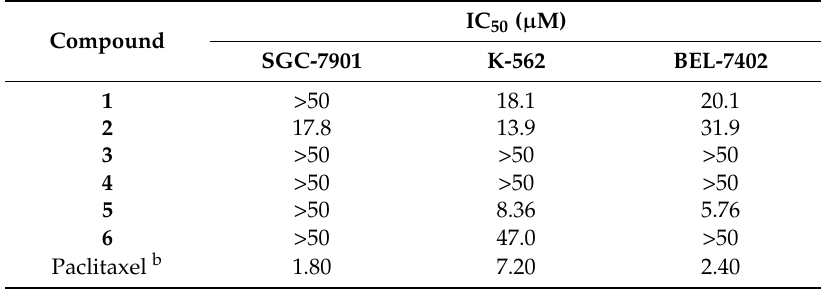
Table 2. Cytotoxic activity of 1 – 6 against human tumor cell